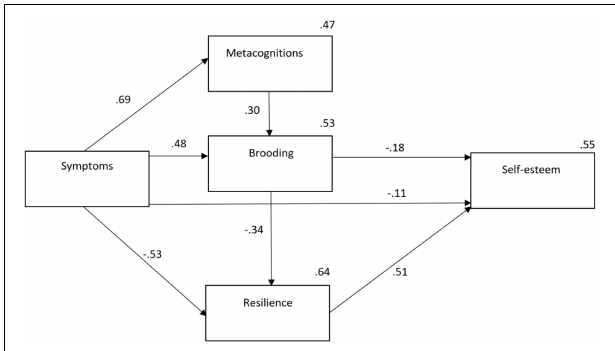
TABLE 2 | Summary of the hierarchical regression analyses with Rosenberg Self-Esteem Scale as the dependent variable ( n = 725). Step Variable Adj. R